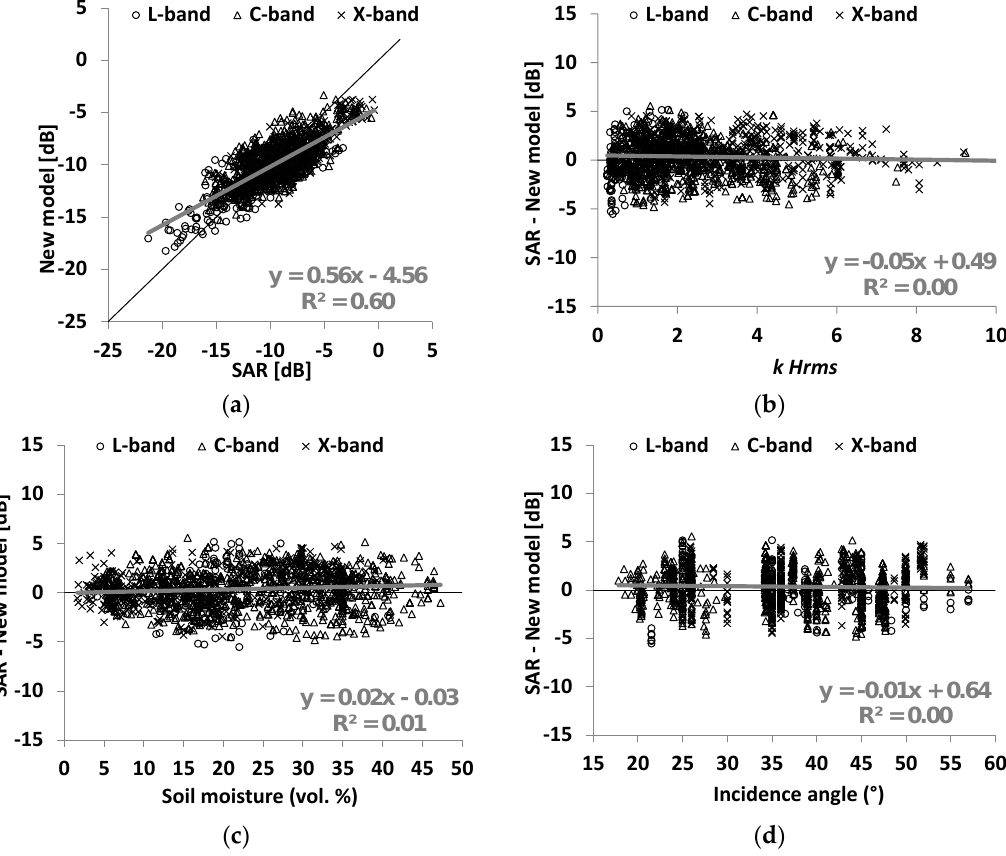
Figure 3. ( a ) Comparison between σ ◦ modelled in the new model and σ ◦ measured (for all SAR bands) for HH polarization; ( b ) the difference between SAR and the new model as a function of surface roughness ( kHrms ); ( c ) the difference between SAR and the new model as a function of soil moisture ( mv ), and ( d ) the difference between SAR and the new model as a function of incidence angle. The best regression model is plotted in gray. Table 3. Comparison between the results obtained with the Dubois model and those obtained with the new model. Bias = real − model.